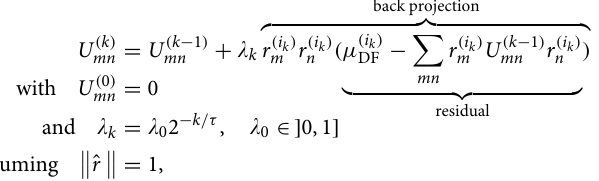
2 ) and arbitrarily scaled to σ 3 /σ 2 = =